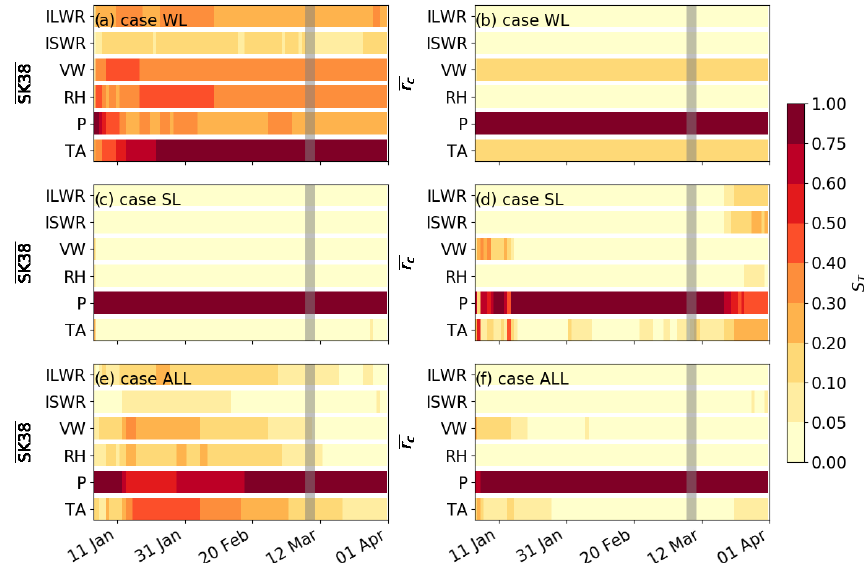
Figure 9. Evolution of the total sensitivity index S T for the model output SK38 and r c for case WL, case SL and case ALL (from top to bottom). Grey vertical bars highlight a period of high avalanche